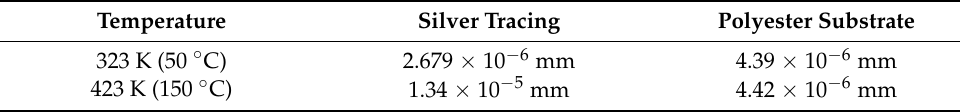
Figure 12. Displacement (in mm) of the polyester substrate at 423 K. Table 6. Maximum displacement in the deformation analysis.